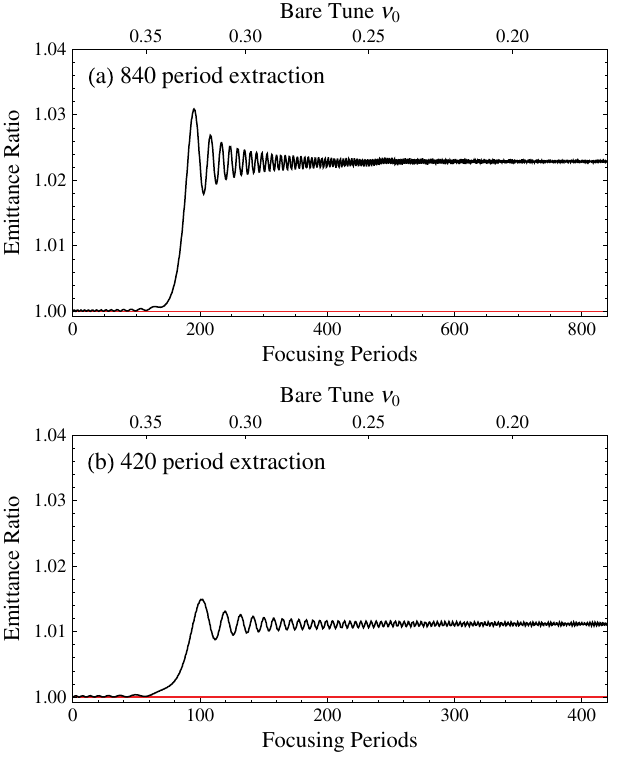
FIG. 3. Multiparticle simulation results without space-charge interactions. The ordinate represents the average of horizontal and vertical rms emittances normalized by its initial value. The rf voltage on the quadrupole electrodes are quickly reduced to move the operating point of the LPT. The initial and final bare tune per single rf period have been set at (cid:5) 0 ¼ 0 : 4 and 0.17, respectively. In the upper example (a), the (cid:5) 0 sweep from 0.4 to 0.17 is completed within 840 rf periods. The sweep speed is twice faster in the lower example (b). Low-order nonlinearities have been intentionally enhanced in these simulations, consid- ering the possible electrode misalignments of 0.1 mm. For reference, simulation results without the misalignments are plotted with red lines, which indicate almost no emittance